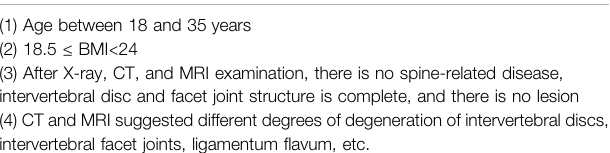
TABLE 3 | Inclusion criteria of the normal group. Inclusion criteria of the normal group